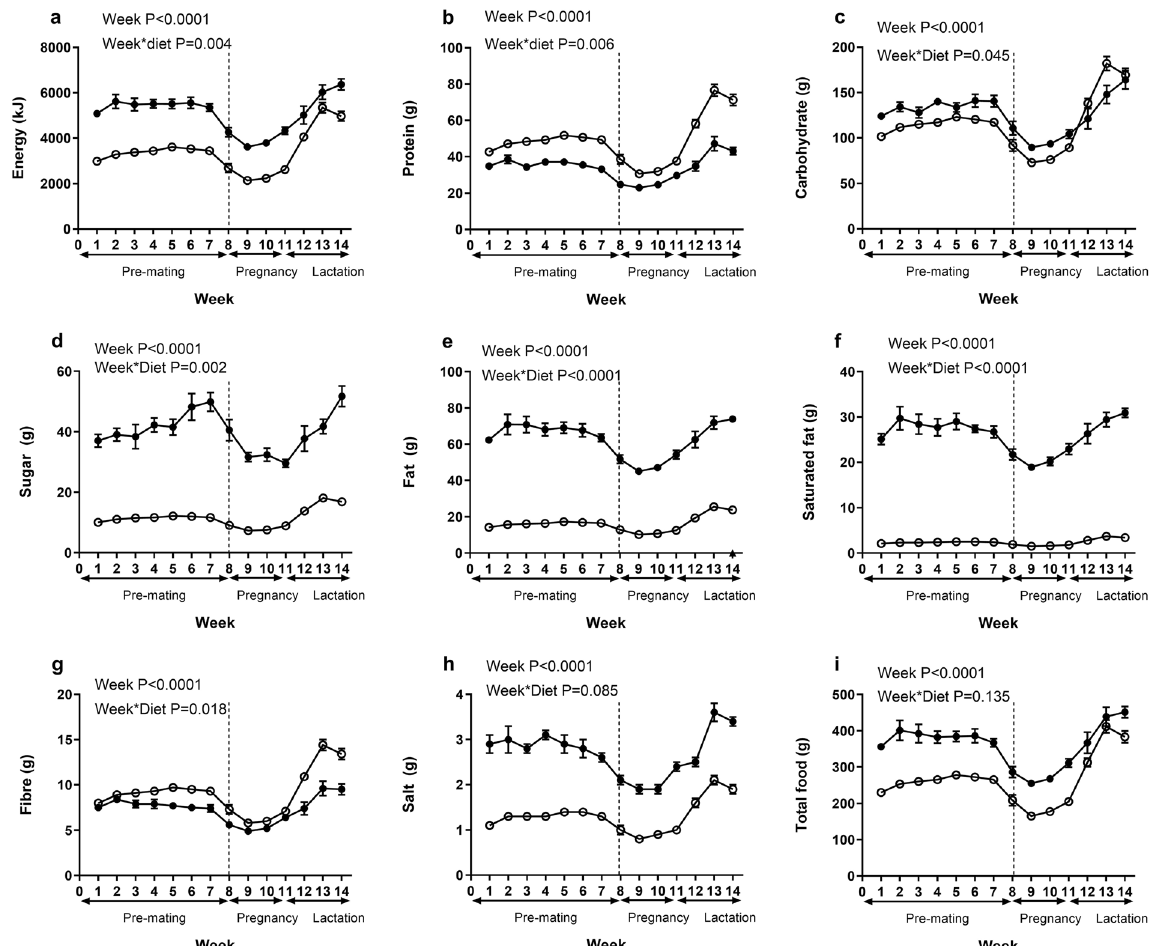
Figure 2. Maternal nutrient intakes. Values are for mean and SEM. Effect of maternal diet on intakes of: ( a ) energy, ( b ) protein, ( c ) carbohydrate, ( d ) sugar, ( e ) fat, ( f ) saturated fat, ( g ) fibre, ( h ) salt, ( i ) total food. Pre- mating (weeks 0–8), pregnancy weeks (8–11), lactation (weeks 11–14). Animals were fed either a control diet (C, open circles n 14–16) or a cafeteria diet (O, closed circles, n 13–16). Food intakes are shown for total intake of animals pair housed during pre-mating and single-housed during pregnancy and lactation. Pair and single housed data is separated by the dashed line at week 8. Some animals were excluded from the analysis due to assessment of extreme outliers or data missing. Statistical analysis was by repeated measures ANOVA.